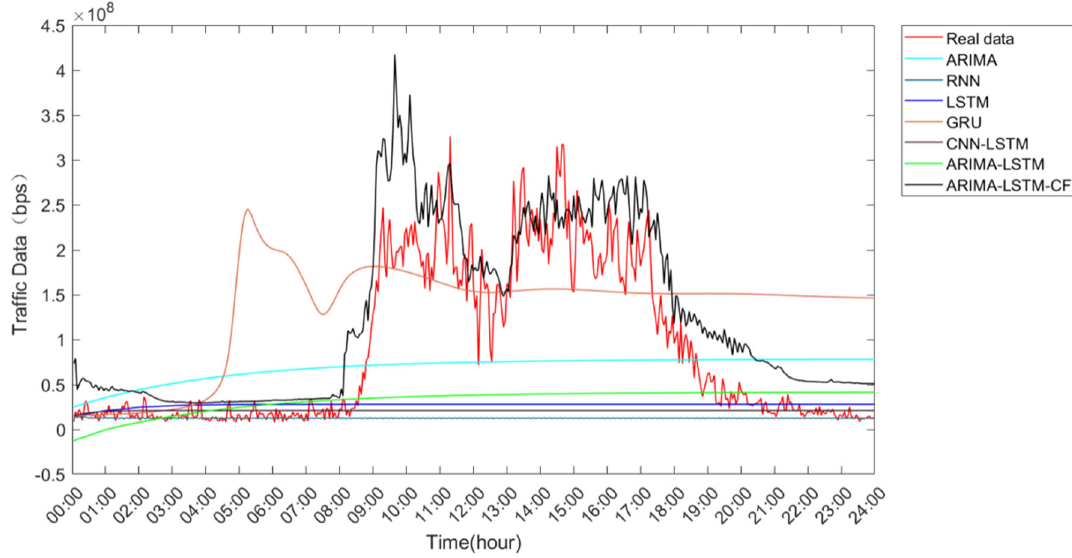
Fig. 11 Single day traffic data prediction results of different prediction models